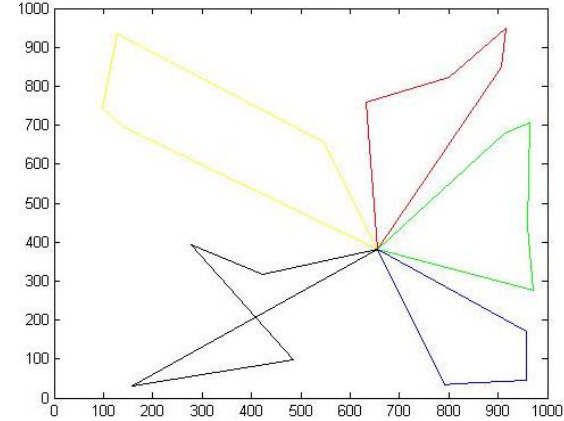
Figure 4. Scenario I, Average answer is 6971.51 m, average time is 45s.